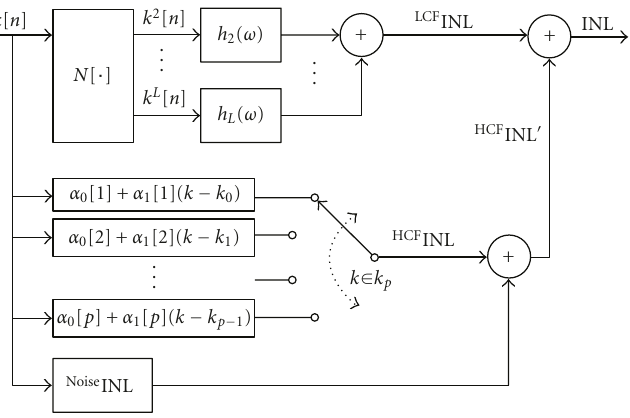
Figure 5: A block scheme over the complete INL model. The nonlinear block N [ · ] is a